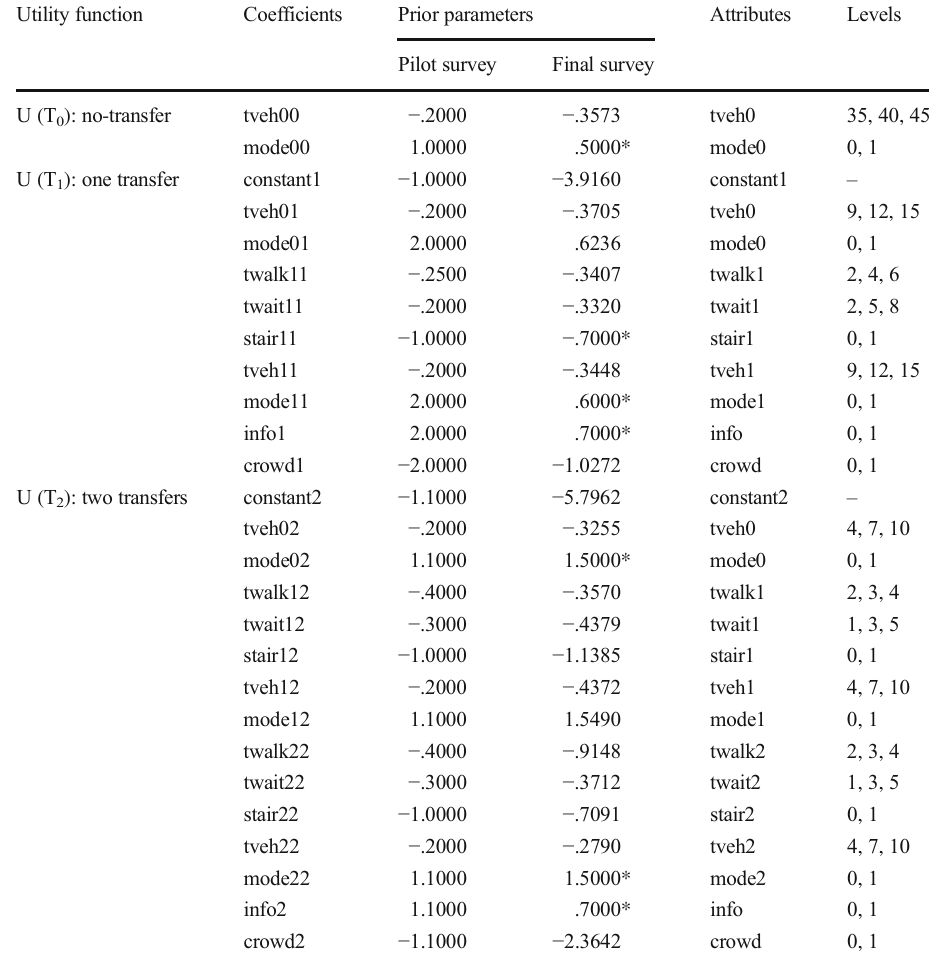
Utility function Coefficients Prior parameters Attributes Levels